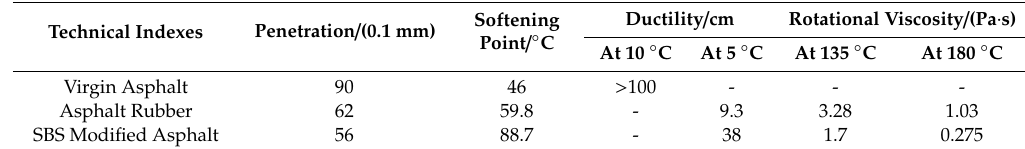
Table 2. Main technical indexes of three asphalt